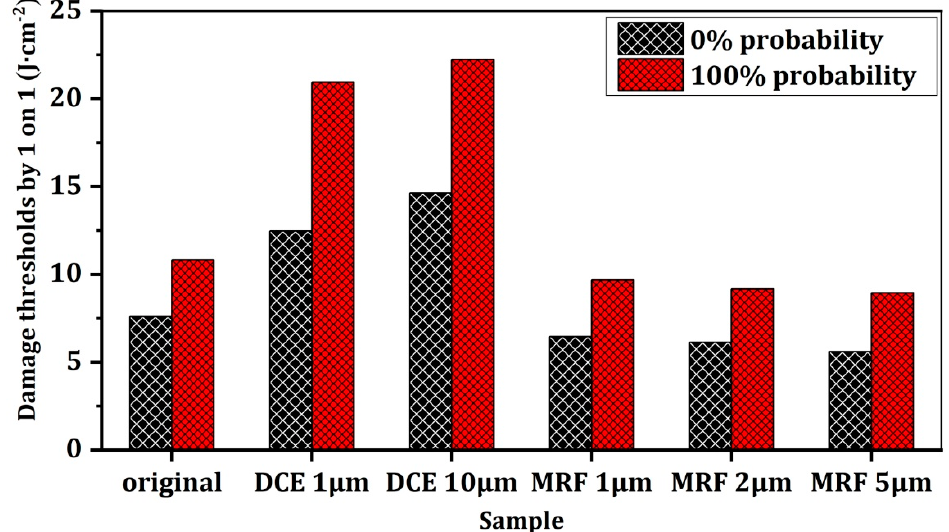
Figure 5. Damage thresholds for all the fused silica samples. Black columns represent the zero-probability damage thresholds and red columns represent 100%-probability damage thresholds.